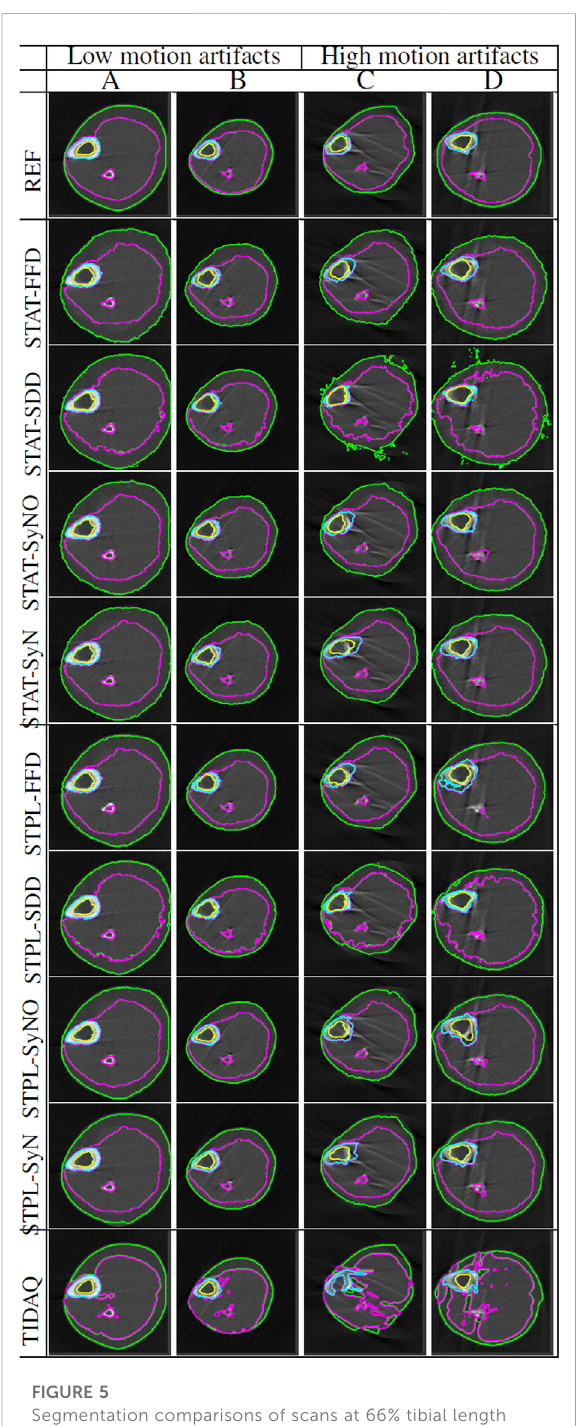
FIGURE 5 Segmentation comparisons of scans at 66% tibial length with low and high levels of artifacts caused by subject motion. Scans (A,B) have low motion artifacts, while scans (C,D) have high motion artifacts. The delineation of the subcutaneous adipose tissue (SAT) is represented by the green contour, muscle by magenta color, cortical bone by cyan color, and trabecular bone by yellow color.